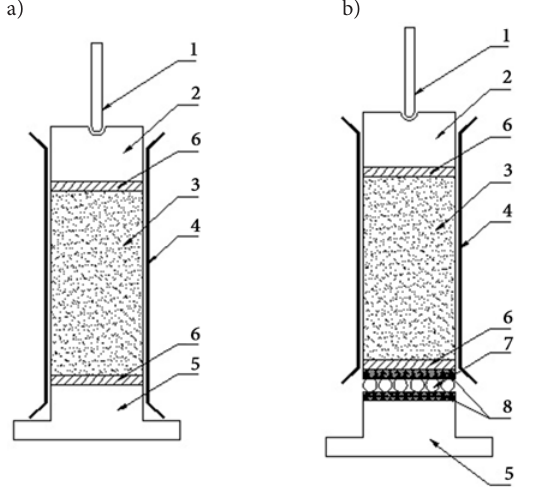
Fig. 1. Boundary conditions of samples for triaxial